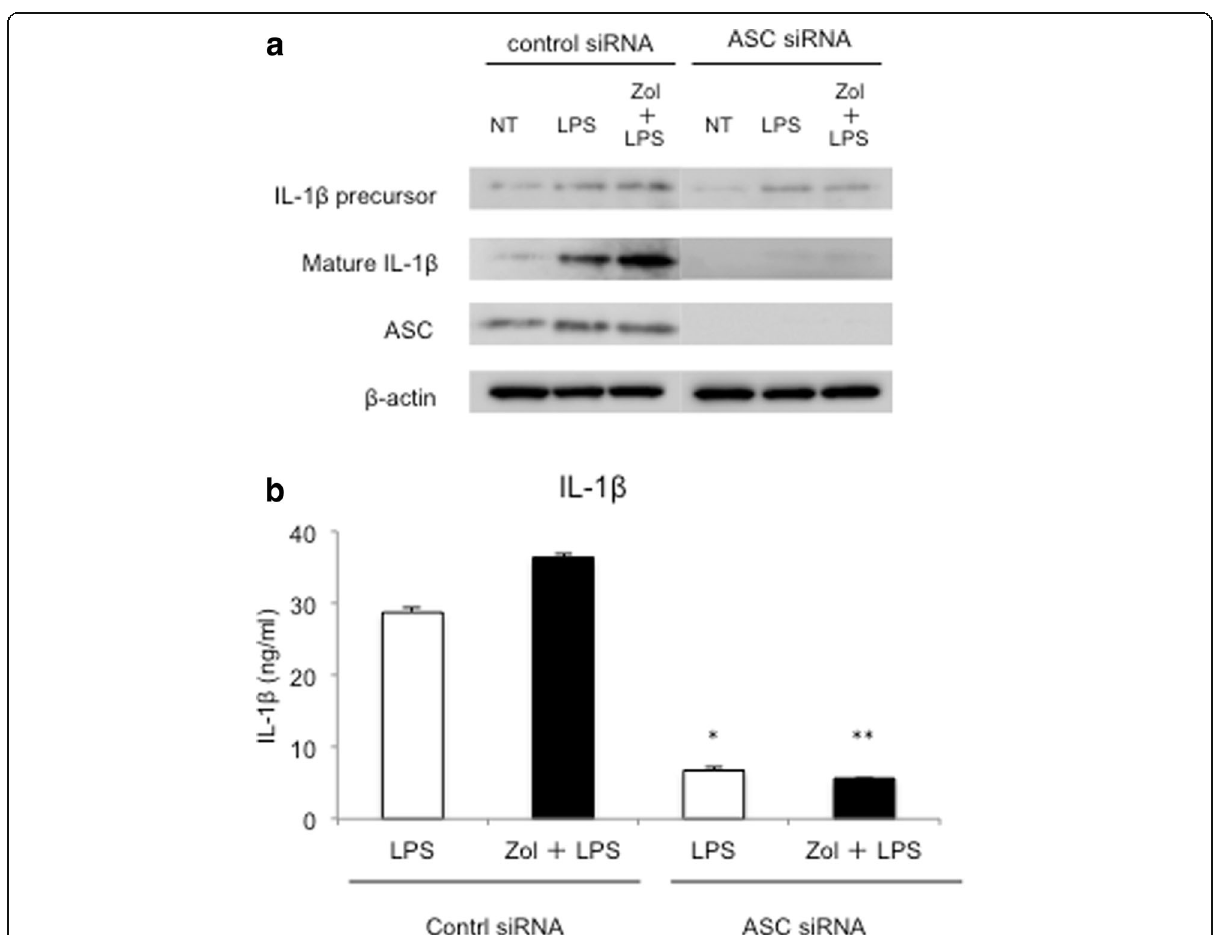
Fig. 3 Role of NLRP3 in IL-1 β secretion induced in LPS-treated THP-1 cells. THP-1 cells were treated with siRNA against ASC, incubated overnight with 100 ng/ml PMA, washed with PBS, and incubated further with or without Zol for another 24 h. THP-1 cells were then treated with 100 ng/ml LPS. ATP was applied to LPS-treated cells for 30 min before collecting samples. a Protein expression was detected by western blotting. Silencing of ASC downregulated the expression of the mature IL-1 β in LPS-treated THP-1 cells. b The secretion of IL-1 β was detected by ELISA. Open bars represent LPS-treated THP-1 cells; filled bars represent Zol and LPS-treated THP-1 cells. Silencing of ASC reduced the secretion of IL-1 β in LPS-treated THP-1 cells (* P <0.01 vs. control siRNA THP-1 cells treated with LPS alone, * * P <0.01 vs. control siRNA THP-1 cells treated with Zol and